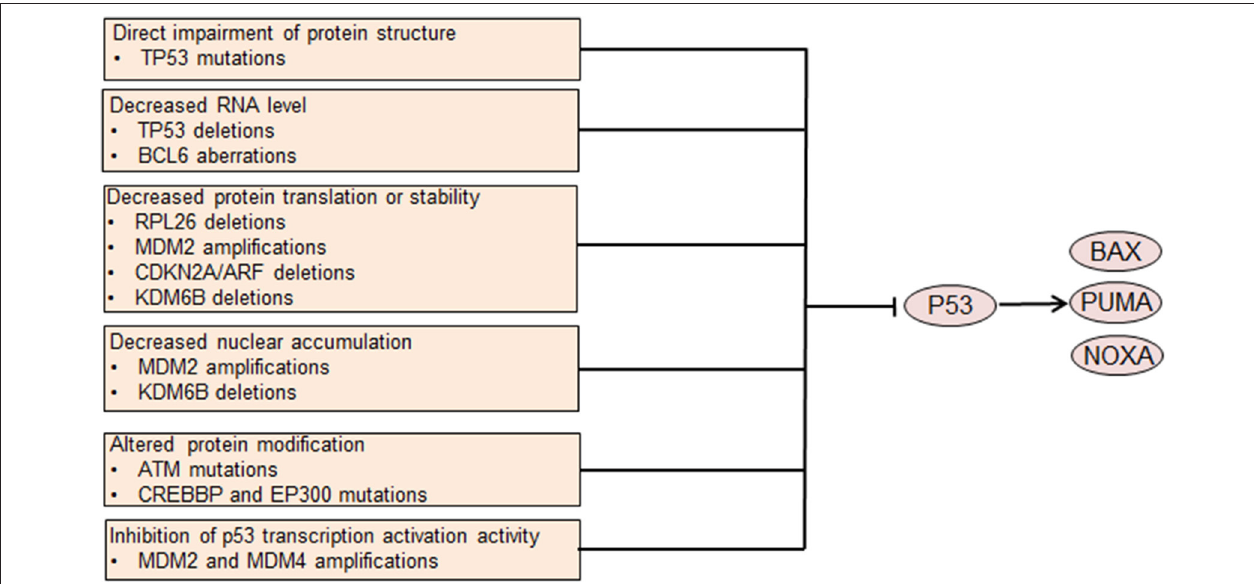
FIGURE 2 | Genetic aberrations causing p53 dysfunction leads to dysregulated cell survival. Mutations involving the coding DNA sequence region of the TP53 gene affect the protein structure and abrogate p53 tumor suppressor function. Other aberrations lead to decreased p53 translation or stability or altered protein modification. MDM2 and MDM4 also inhibit p53-mediated transcription activation. Decreased p53 nuclear accumulation caused by MDM2 amplifications or KDM6B deletions leads to p53 dysfunction. Impaired p53 function leads to decreased transcription of pro-apoptotic genes, resulting in abnormally enhanced cell survival.